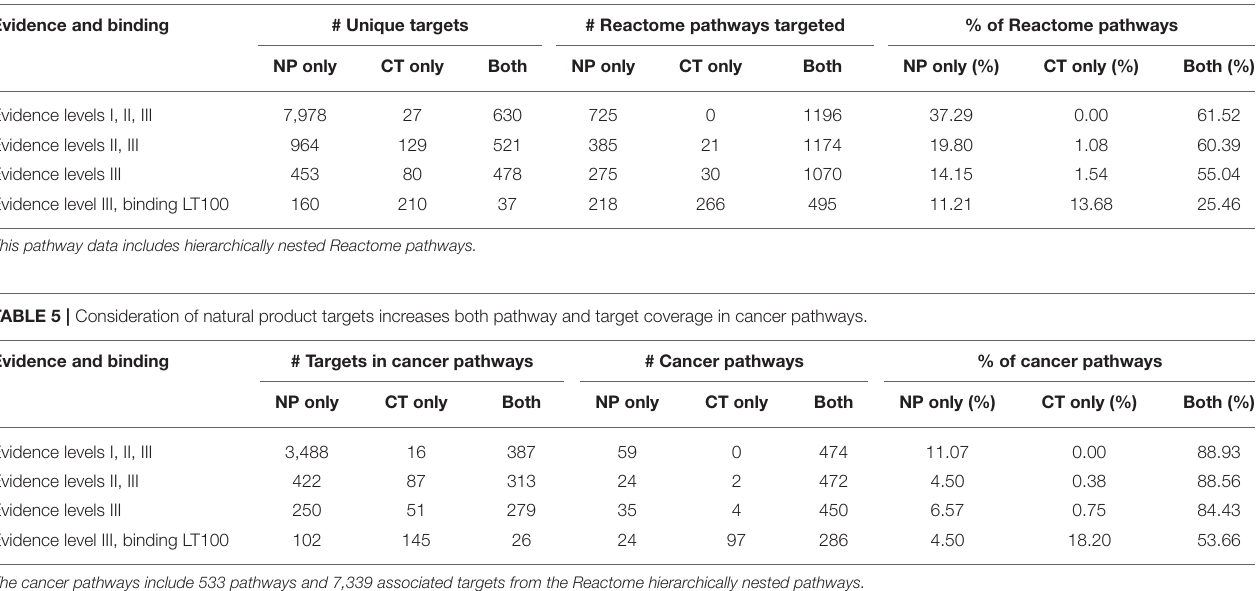
TABLE 4 | Consideration of natural product targets increases both pathway and target coverage in all Reactome pathways.